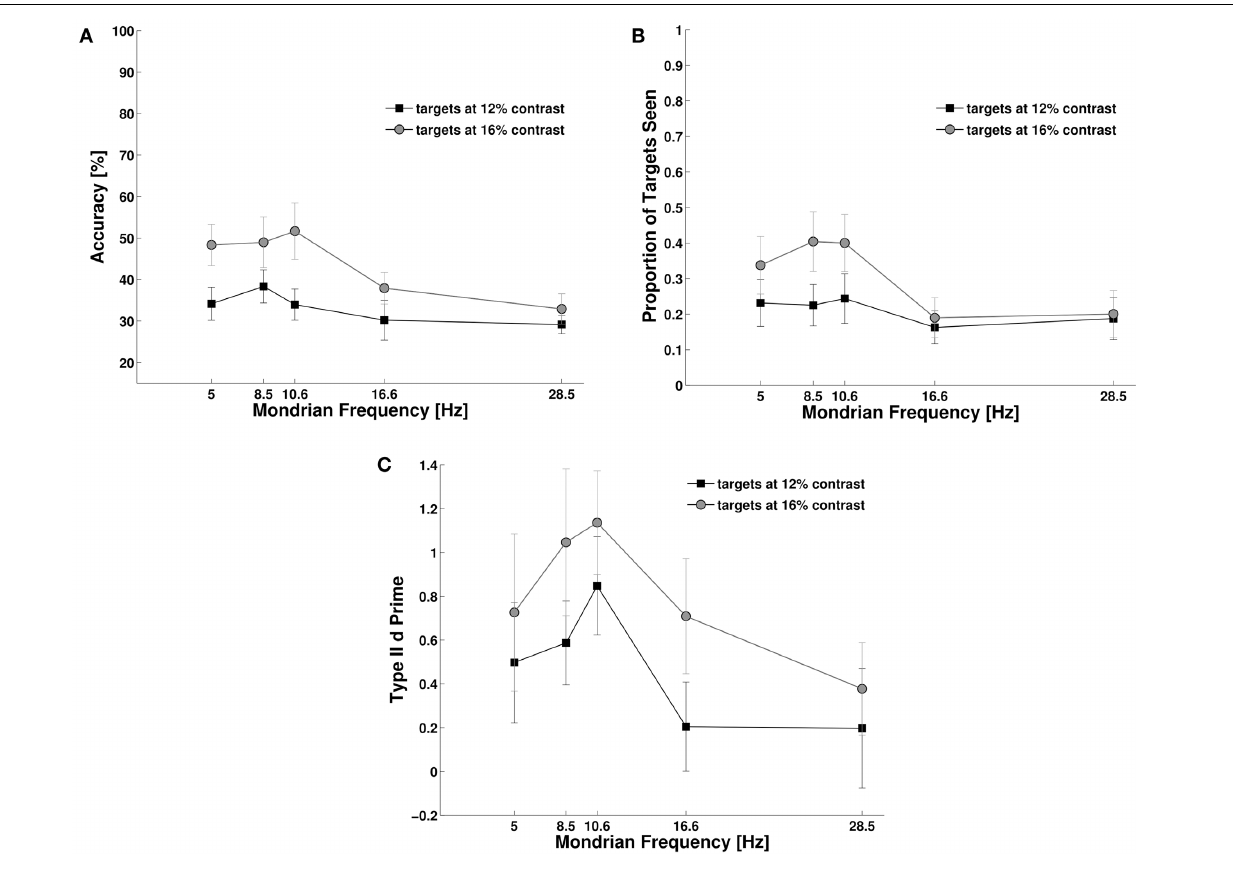
FIGURE 4 | Experiment 3. Control experiment using only two Mondrian masks (“Sandwich Masking”). This experiment generated stronger target suppression than Experiment 2 ( Figure 3 , see Results Section for statistics),